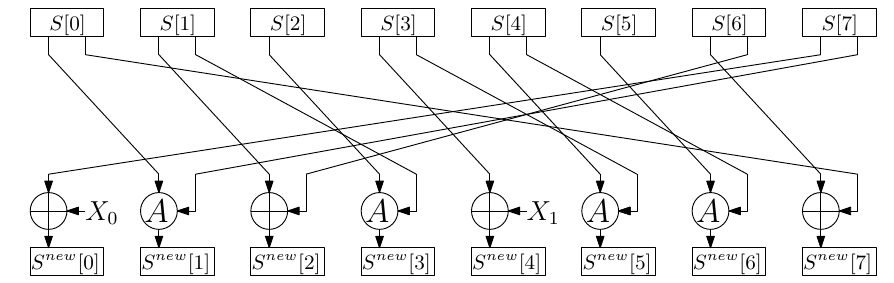
Figure 1: Illustration of the round